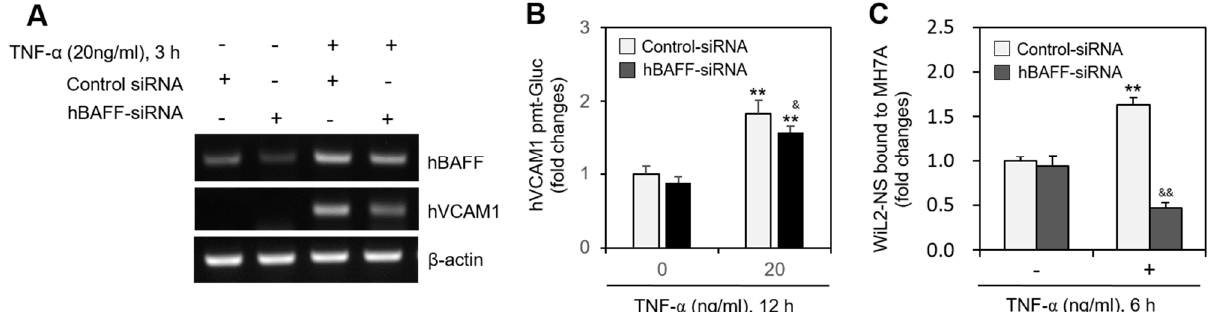
Figure 4. Human vascular cell adhesion molecule-1 (hVCAM1) expression was down-regulated by hBAFF-siRNA. ( A – C ) MH7A cells were transfected with control or hBAFF-siRNA to knockdown hBAFF expression by using Lipofectamine ® . Cells were treated with 20 ng/mL TNF- α . RNA was purified with Nucleozol ® . hVCAM1 and hBAFF expression was detected by RT-PCR ( A ). Cells were transfected with pEZx-PG02-hVCAM1 gaussia luciferase (Gluc) plasmid DNA by using PEI, and treated with 20 ng/mL TNF- α . Gluc activity was measured by using luminometer ( B ). Cells were treated with 20 ng/mL TNF- α for 6 h. Then, WiL2-NS cells were added and co-incubated to adhere for 30 min. Unbound WiL2-NS B cells were washed out and MTT assay was used to analyze bound B cells ( C ). Each experiment was performed at least four times. Data in a bar graph represent the means ± SD. ** p < 0.01; significantly different from control-siRNA-treated and TNF- α -untreated control group. & p < 0.01, && p < 0.01; significantly different from control-siRNA-treated and TNF- α -treated control group ( A , C